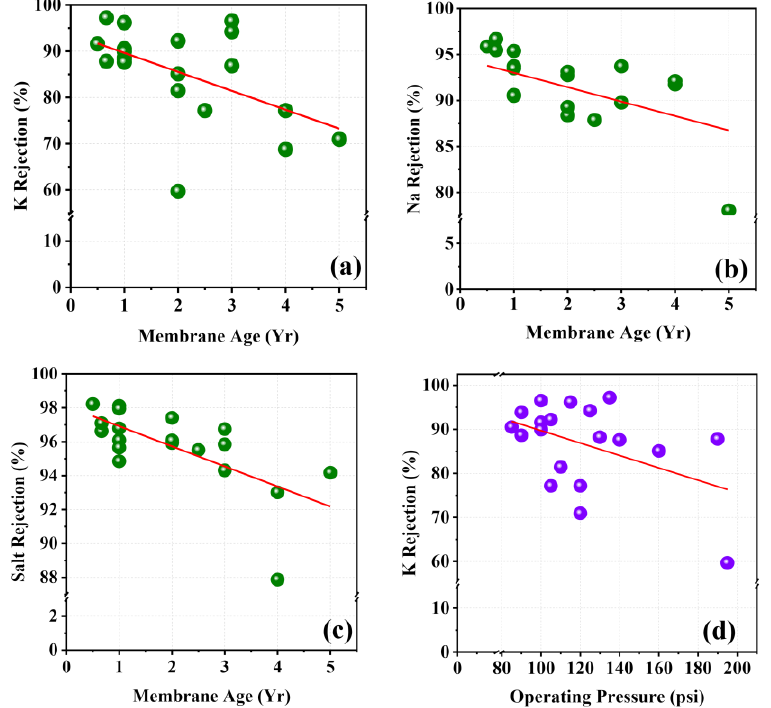
Figure 4. Rejections of monovalent ions with membrane age: ( a ) K rejection, ( b ) Na rejection, ( c ) salt rejection with membrane age, and ( d ) K rejection with operating pressure.